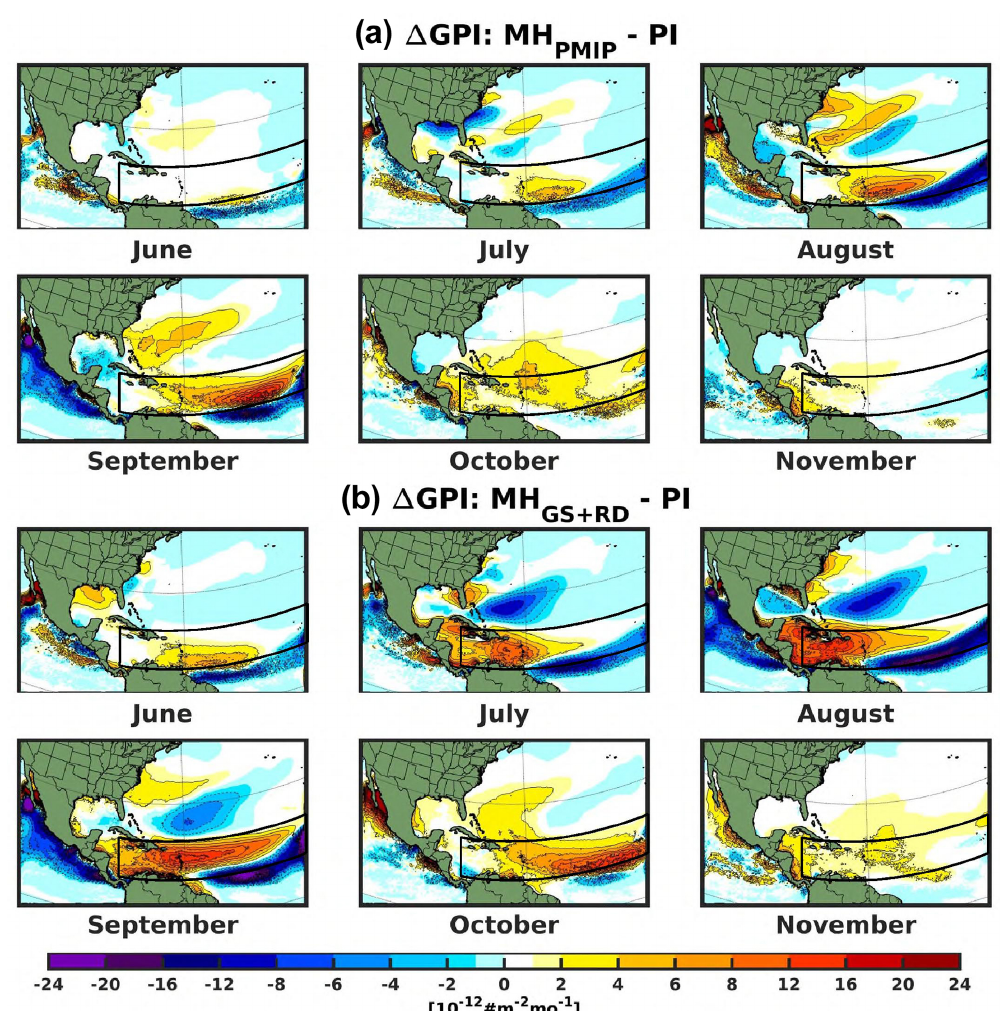
Figure 9. Changes in climatological monthly GPI for (a) MH PMIP and (b) MH GS + RD relative to the PI experiment. The black box shows the approximate present-day MDR. Only values that are significantly different at the 5% level using a local (grid-point) t test are shaded. The contour lines follow the color-bar scale (dashed, negative anomalies; solid, positive anomalies); the 0 line is omitted for